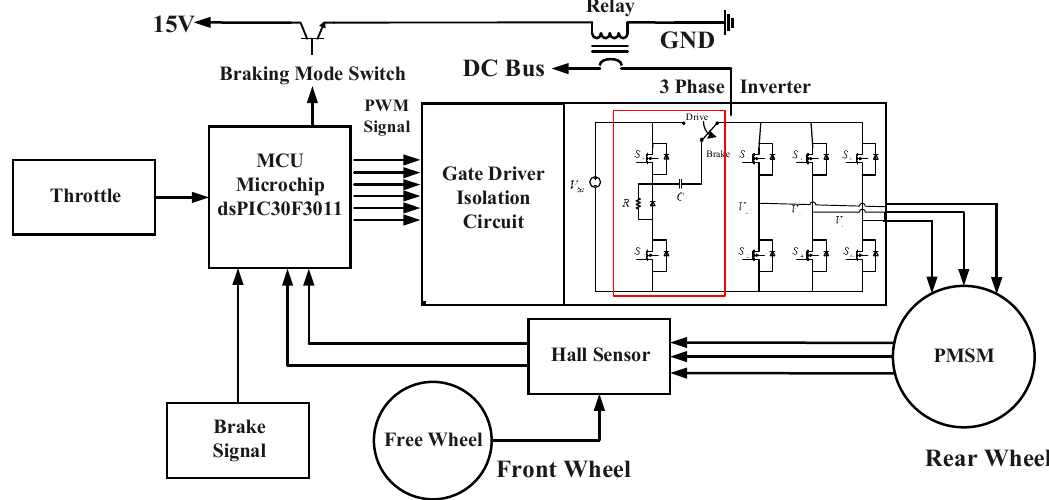
Figure 6. Schematic diagram of the whole system.